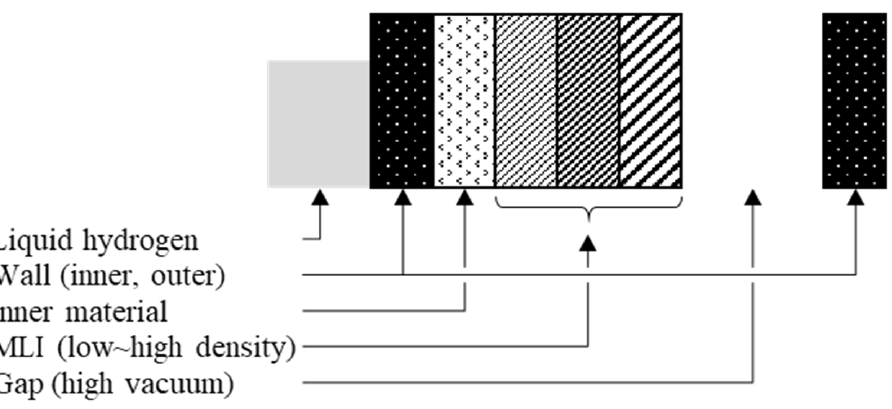
Figure 1. Insulation concept of the multi-purpose hydrogen test bed [4,5].